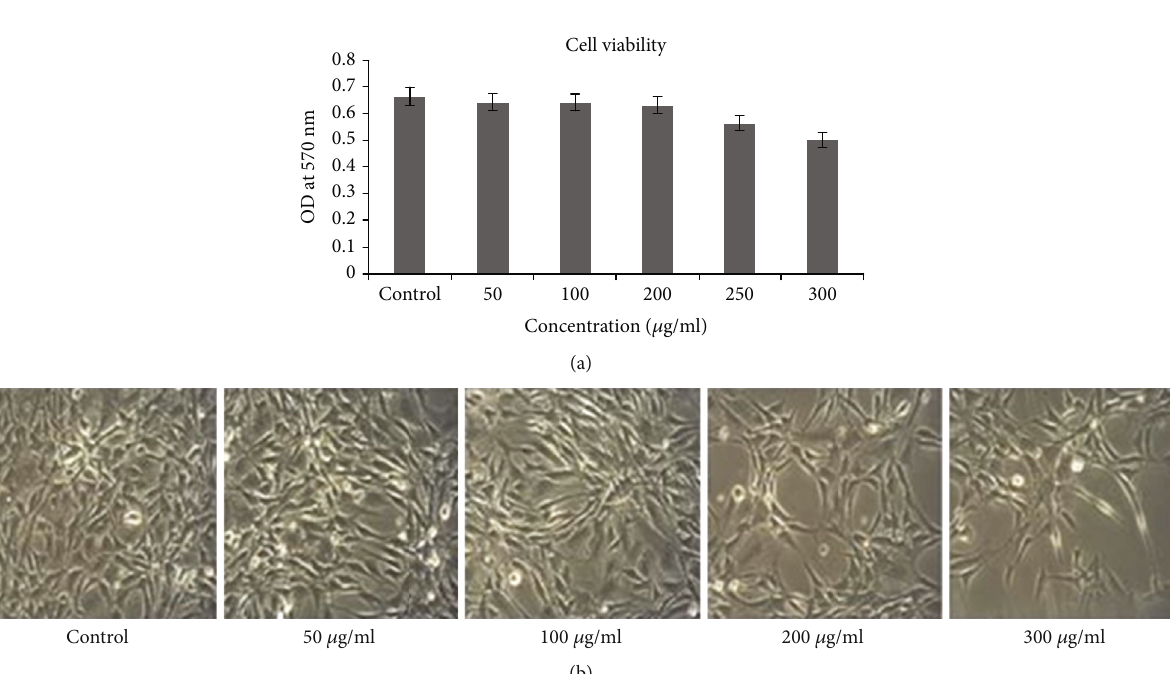
Figure 3: MTT assay of FA (Cells treated above 300 μ g/ml concentration showed a signi fi cant ( p < 0 : 05 ) death of cell; compared with control (a,